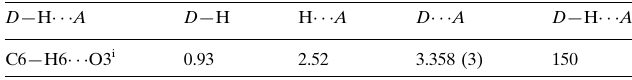
Hydrogen-bond geometry (A˚ , (cid:1)